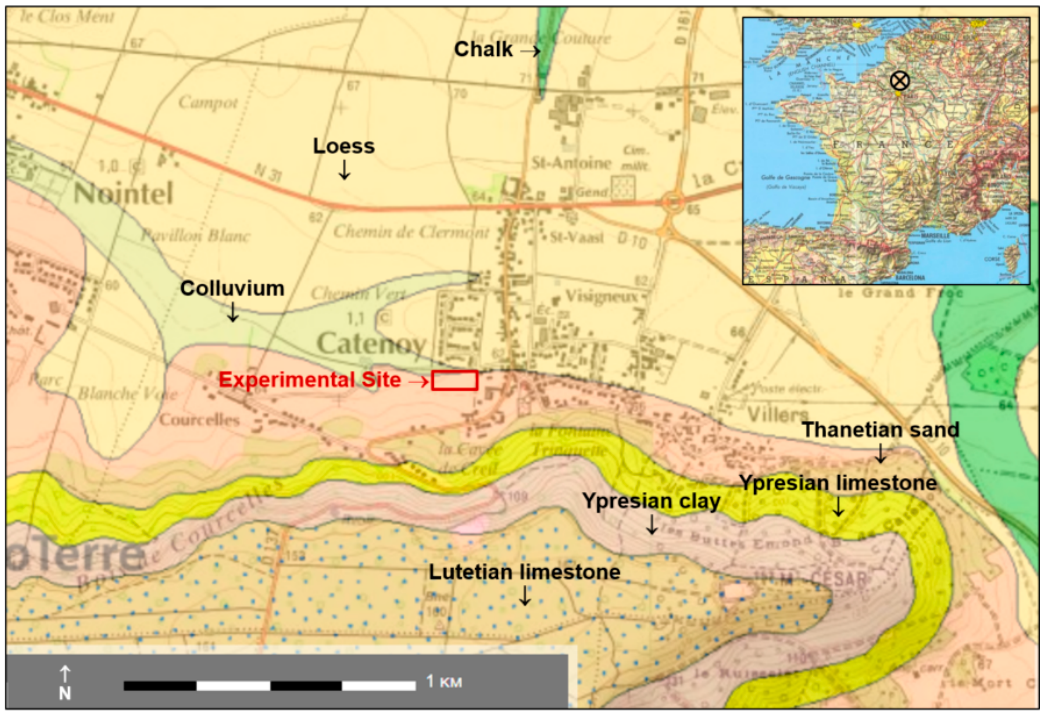
Figure 1. Location and geological context of the experimental site.